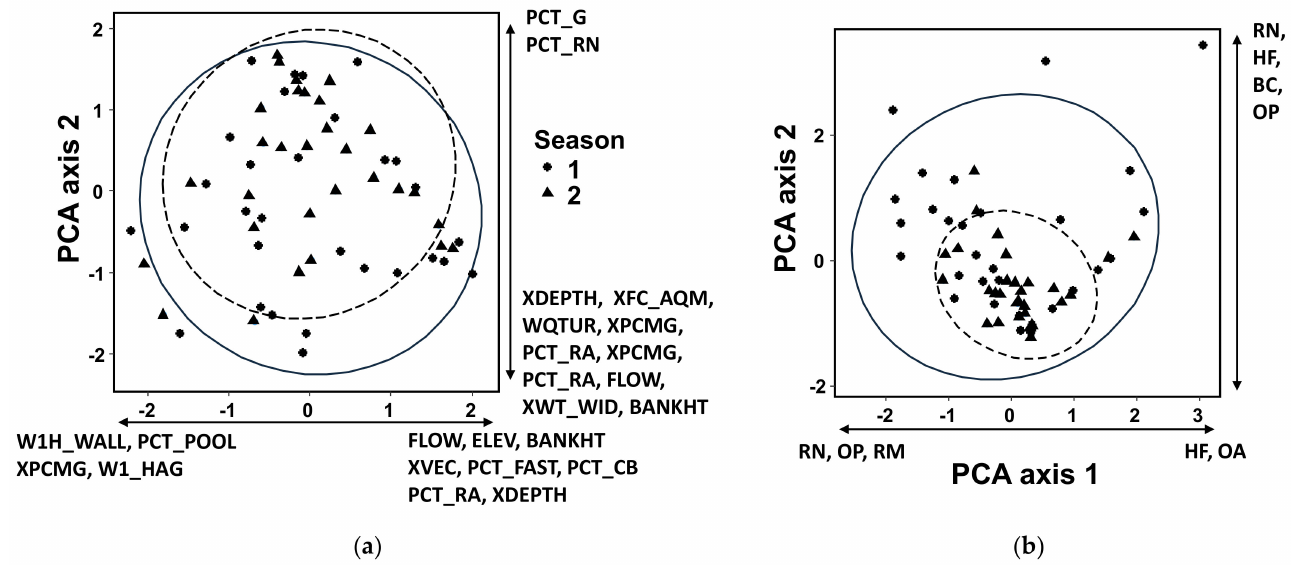
Figure 2. Biplots of principal component analyses of ( a ) habitat variables and ( b ) fish compositions of two seasons. Solid ellipses are for the pre-typhoon season, and dashed ellipses are for the post- typhoon season. Species and habitat variables presented have higher influences (absolute loading values) in their respective directions. According to the results of Procrustes tests, habitat variables and fish communities between the two seasons were significantly different in the ordination space (habitat: sum of square = 0.39, p = 0.001; fish: sum of square = 0.72, p = 0.002). Descriptions of abbreviations of habitat variables are in Table 2, whereas explanations of abbreviations of fish metrics are in Table